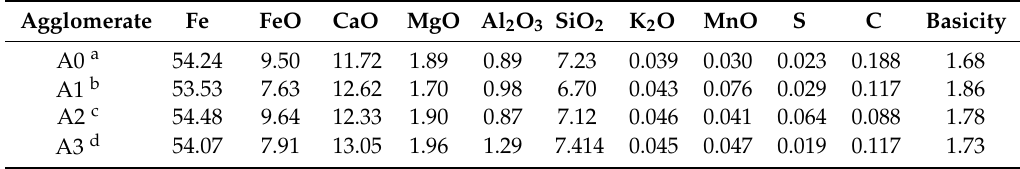
Table 6. Chemical composition (wt%) of